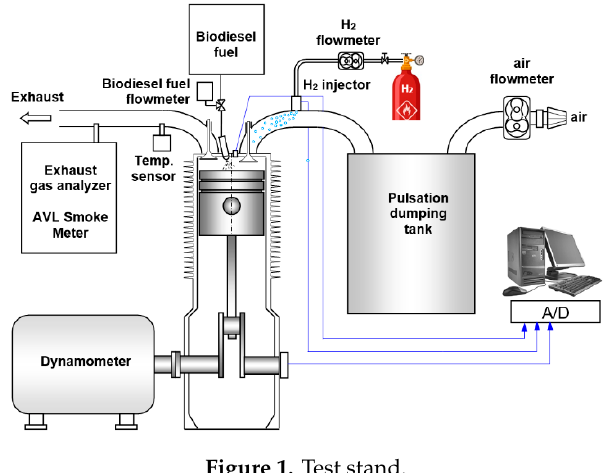
Figure 1. Test stand.